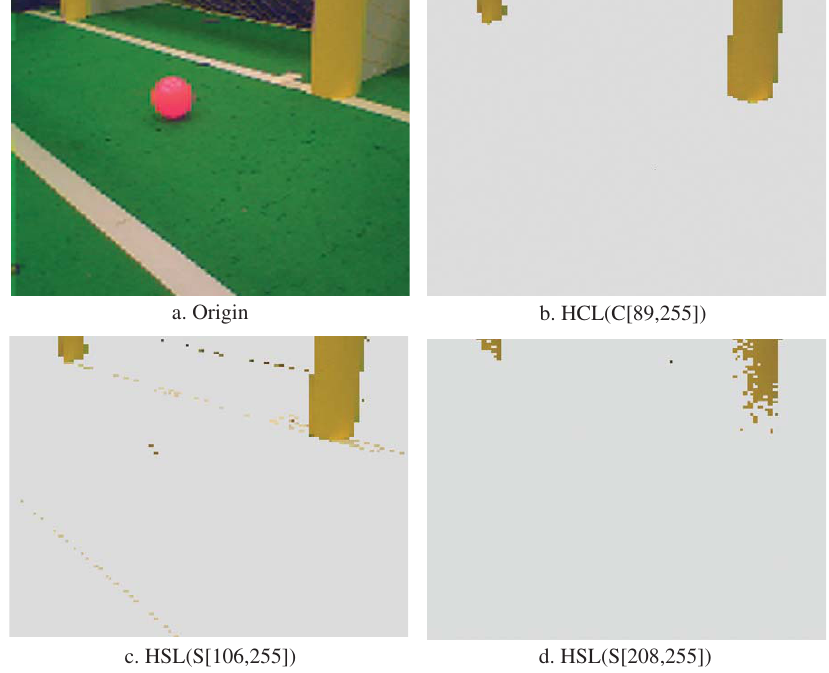
Fig. 11. Colour segmentation results of yellow